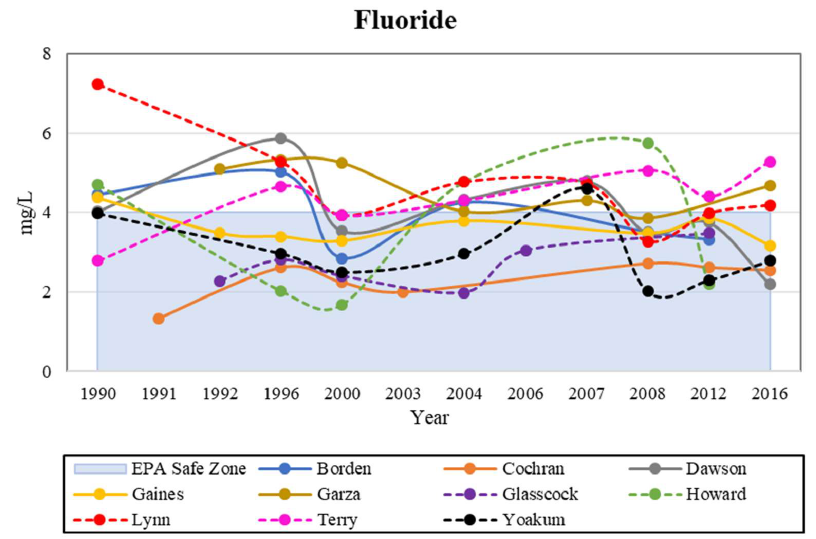
Figure 5. Historical analysis of fluoride levels in the study area, compared with the EPA safe zone.